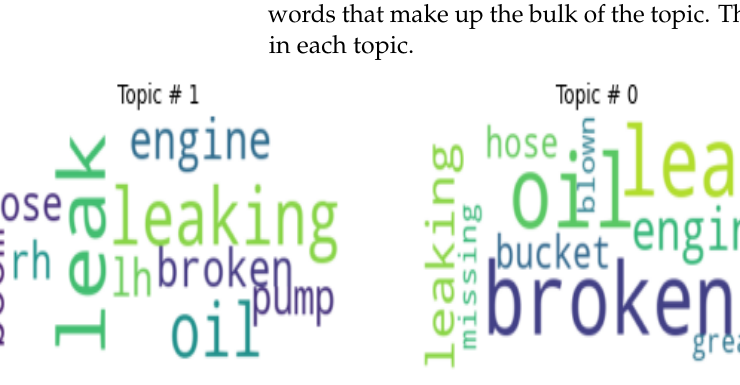
Figure 8. LDA coherence score as a function of the number of topics.